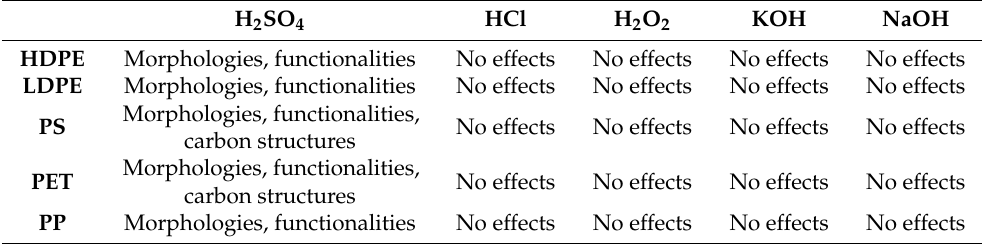
after the reaction with all chemical agents at 70 ◦ C for 7 d. ( c ) FT-IR spectra of PP in the pristine state and after the reaction with all chemical agents at 70 ◦ C for 7 d. ( d ) SEM image of pristine PP microparticles. SEM images of PP microparticles after the reaction with ( e ) H 2 SO 4 , ( f ) HCl, ( g ) H 2 O 2 , ( h ) KOH, and ( i ) NaOH at 70 ◦ C for 7 d. Table 1. The overall effects by the addition of acids, bases, and oxidizing agent on all the MPs. H 2 SO 4 HCl H 2 O 2 KOH NaOH HDPE Morphologies, functionalities No effects No effects No effects No effects LDPE Morphologies, functionalities No effects No effects No effects No effects Morphologies, functionalities, PS No effects No effects No effects No effects carbon structures Morphologies, functionalities, PET No effects No effects No effects No effects carbon structures PP Morphologies, functionalities No effects No effects No effects No effects